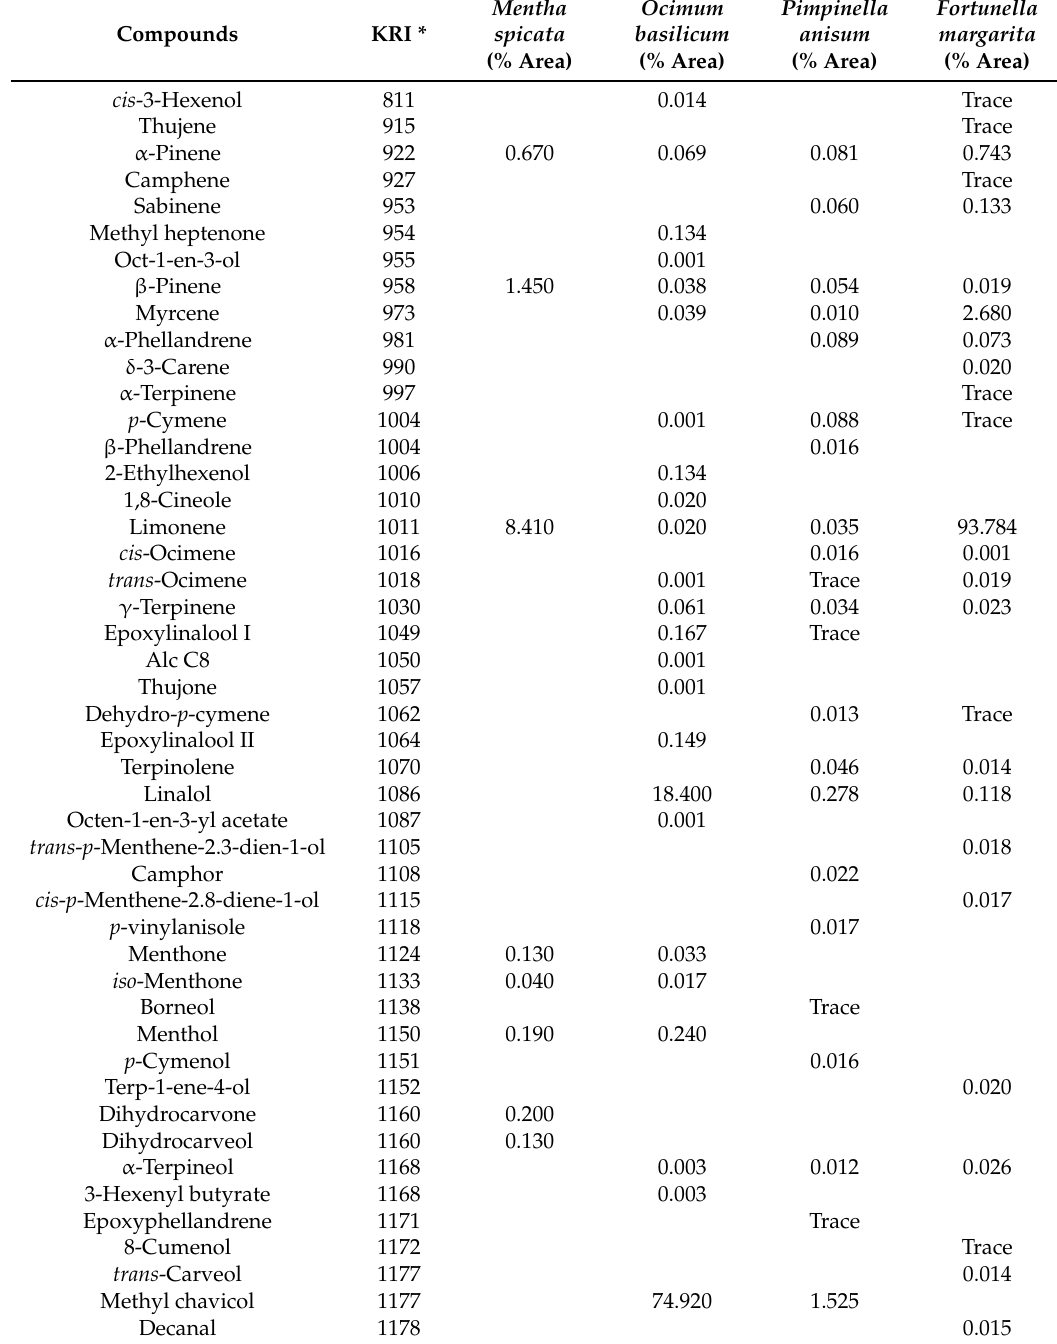
Table 1. Compounds identified in the volatiles of essential oils by GC/MS and their relative percent (%)